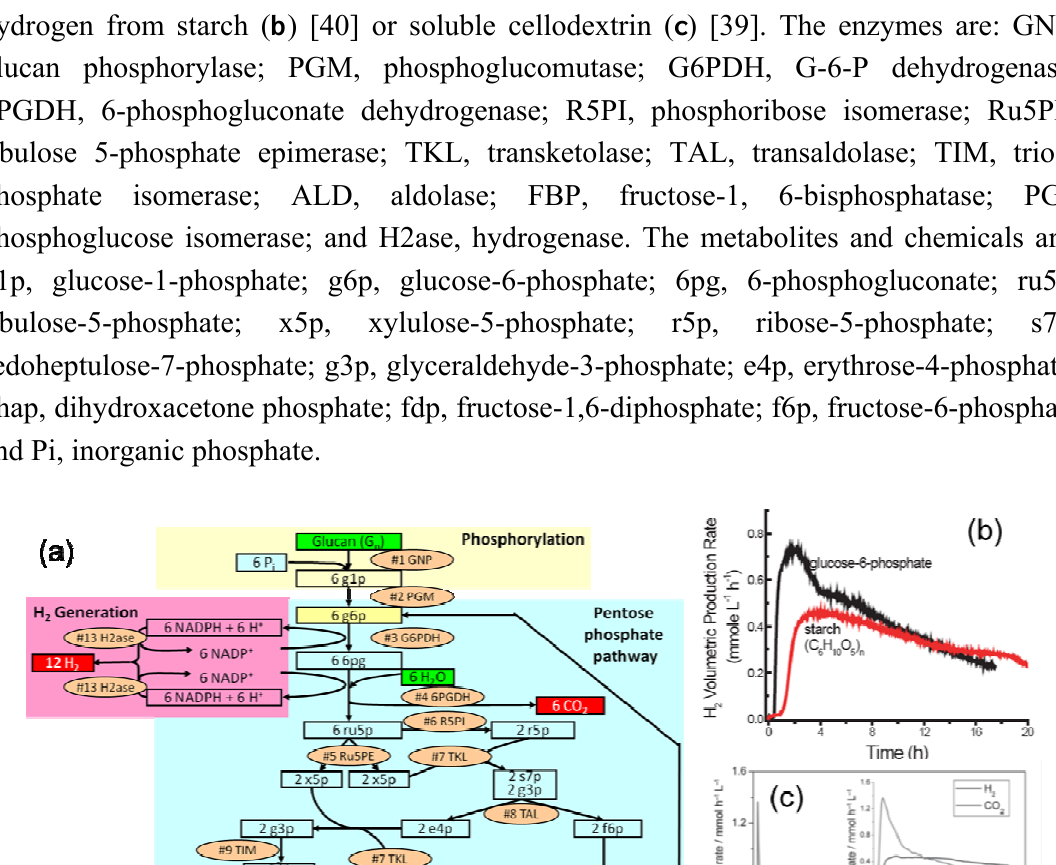
Figure 3. The cell-free synthetic enzymatic pathway ( a ), high-yield generation of hydrogen from starch ( b ) [40] or soluble cellodextrin ( c ) [39]. The enzymes are: